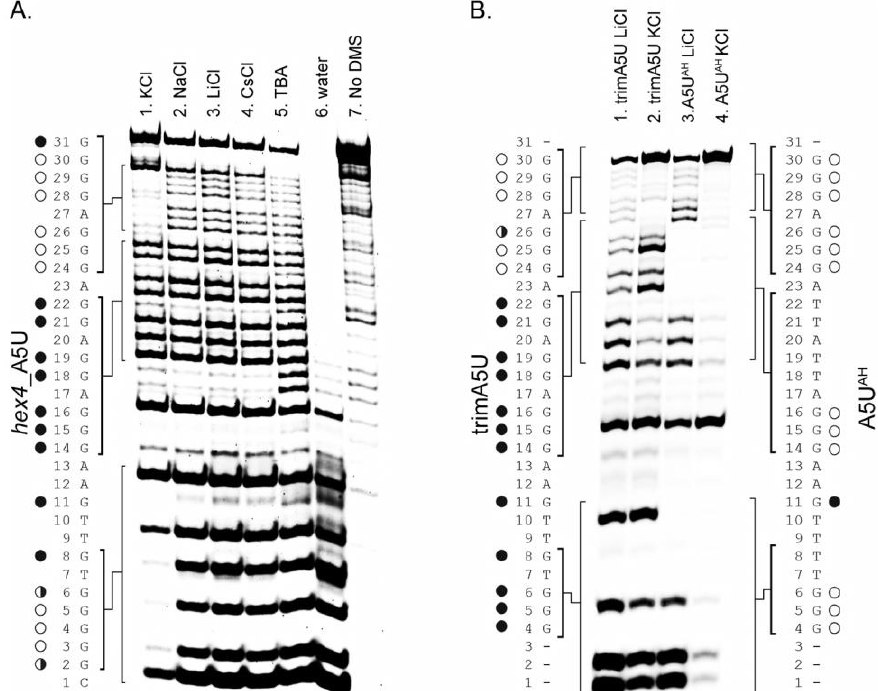
Figure 4. Dimethyl sulfate (DMS) footprinting of hex4 _A5U and its variations reveal guanines involved in G4 core formation. ( A ) Missing bands on a gel indicate guanines protected from DMS labeling. A distinct footprinting pattern is observed only for the KCl sample (lane 1). In NaCl, LiCl, and CsCl, partial protection is observed for the GGGAGGG hairpin at the 5′ end of the oligonucleotide (lanes 2–4). In TBA, all guanines are digested evenly and in water alone the sample is overdigested. Circles (left) indicate guanines that are protected ( ○ ), partially protected ( ◗ ), or overdigested ( ● ) when treated in KCl. ( B ) hex4 _A5U was trimmed by removing bases 1, 2, 3, and 31, resulting in trimA5U construct. trimA5U was further altered by substituting G 8 , G 18 , G 19 , G 21 , and G 22 with thymidines, resulting in A5U AH construct. Both trim_A5U and A5U AH oligonucleotides were subjected to DMS footprinting in KCl or LiCl.